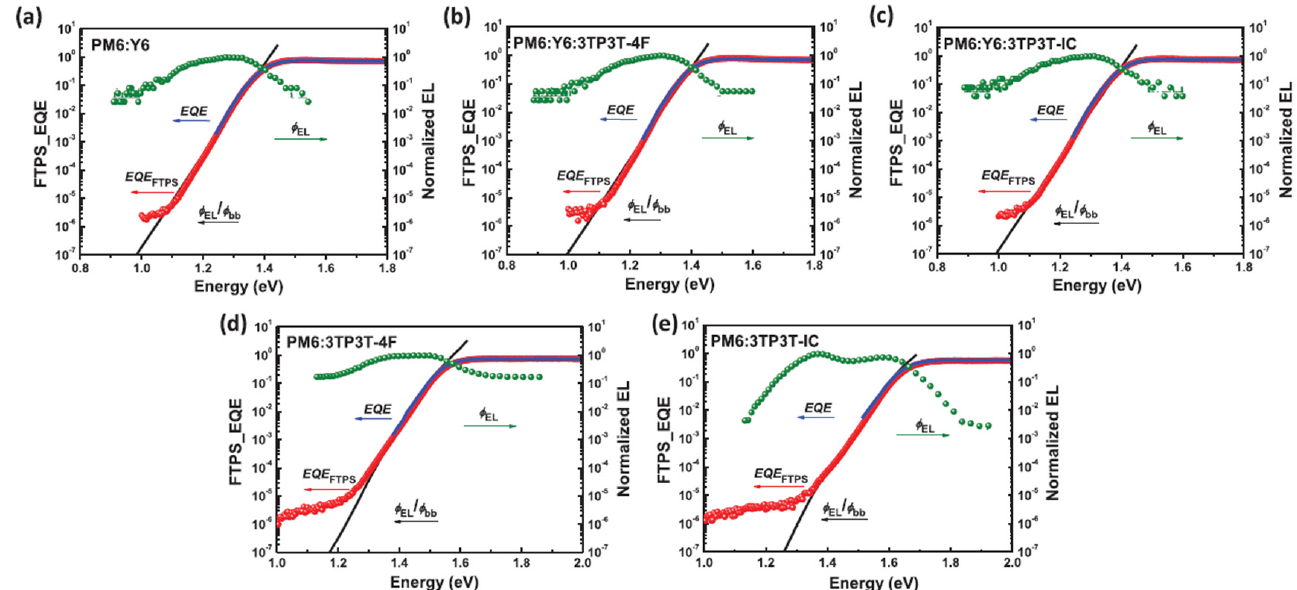
Figure 9. ( a – e ) Intensity of FTPS-EQE and their fitting. Reproduced from [82]. Reprinted with permission from ref. [82]. Copyright 2019 Wiley.